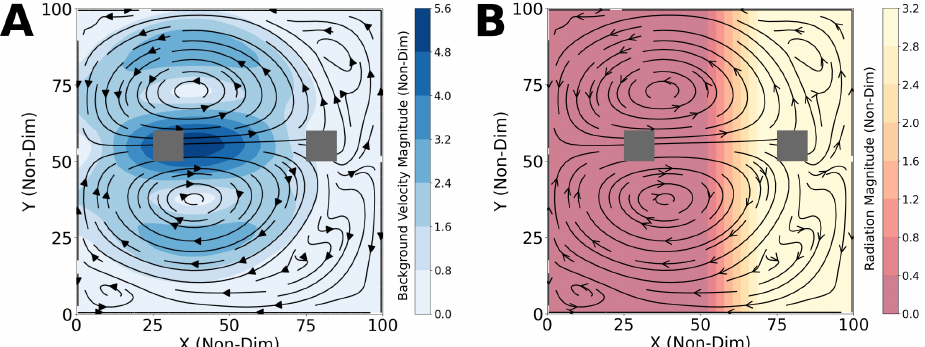
Figure 2. Mission Environment ( A ) An example realization at t = 0 of the stochastic double gyre flow shown as streamlines overlaid on a color plot of the magnitude. ( B ) Same as A, but showing an example scalar radiation field as the background color, on which the velocity streamlines are placed. The dynamic obstacles are shown as gray filled